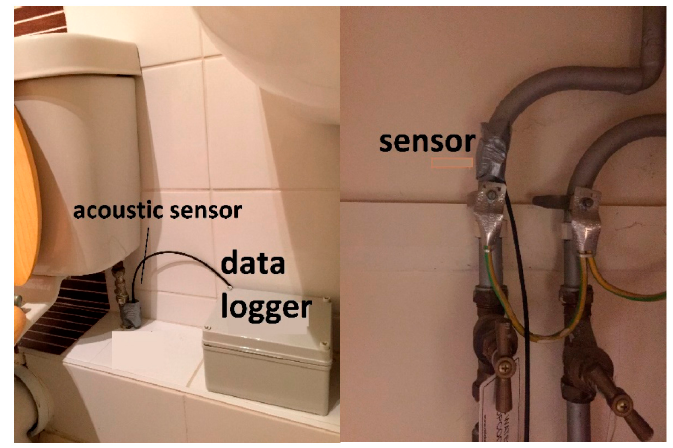
Figure 3. Acoustic sensors deployment for in-house water monitoring.